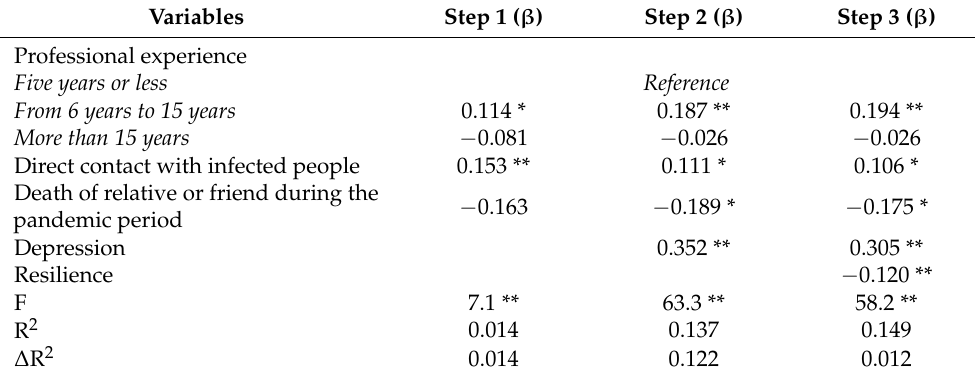
Table 4. Hierarchical linear regression analysis results (outcome variable: client-related